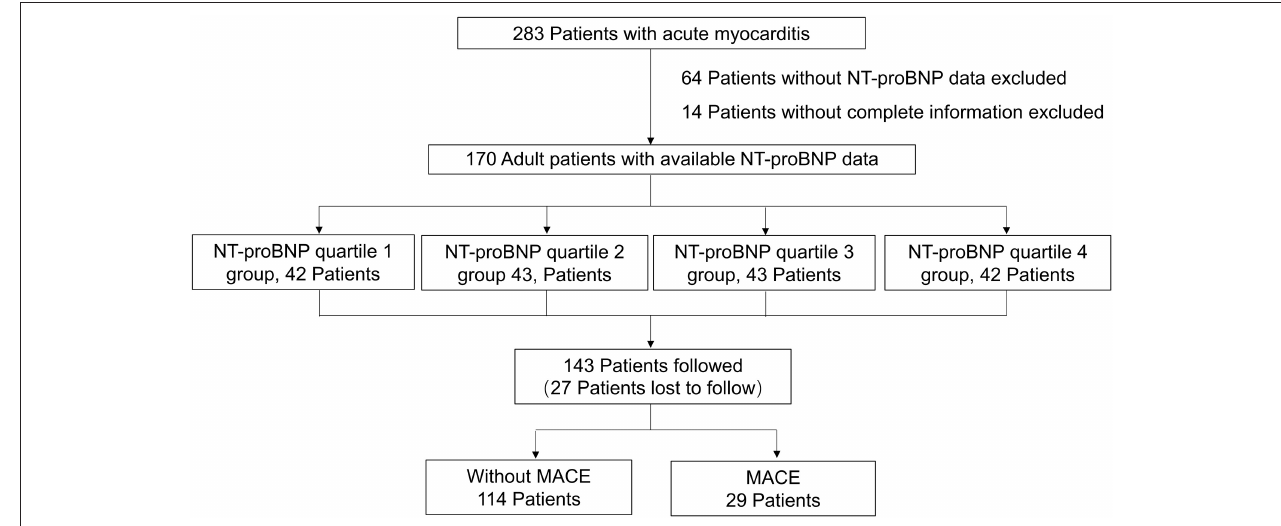
FIGURE 1 | The flow chart of the enrollment of 170 adult patients with acute myocarditis from the overall population with acute